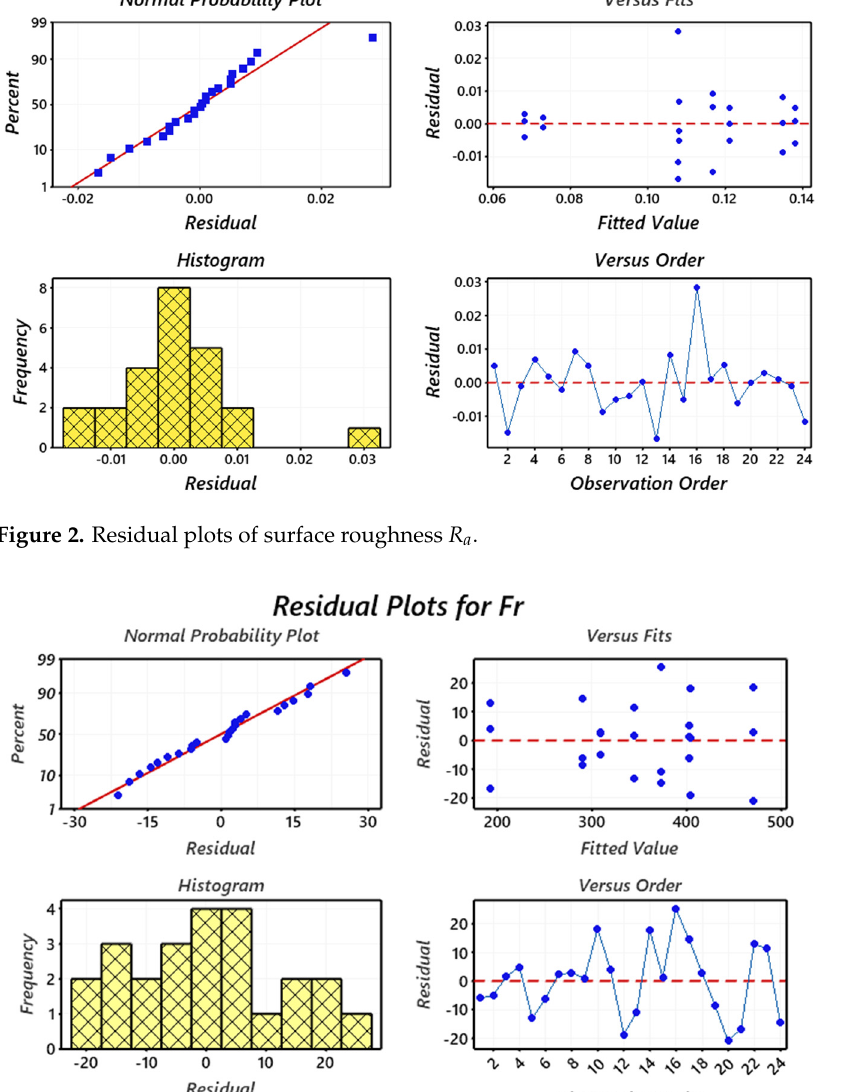
Figure 3. Residual plots of resultant cutting force F r.